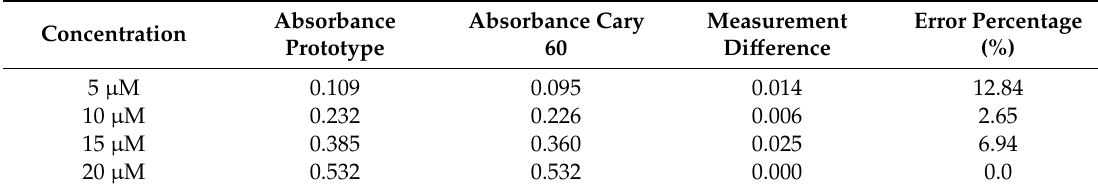
Table 4. Measurements of coumarin concentration.